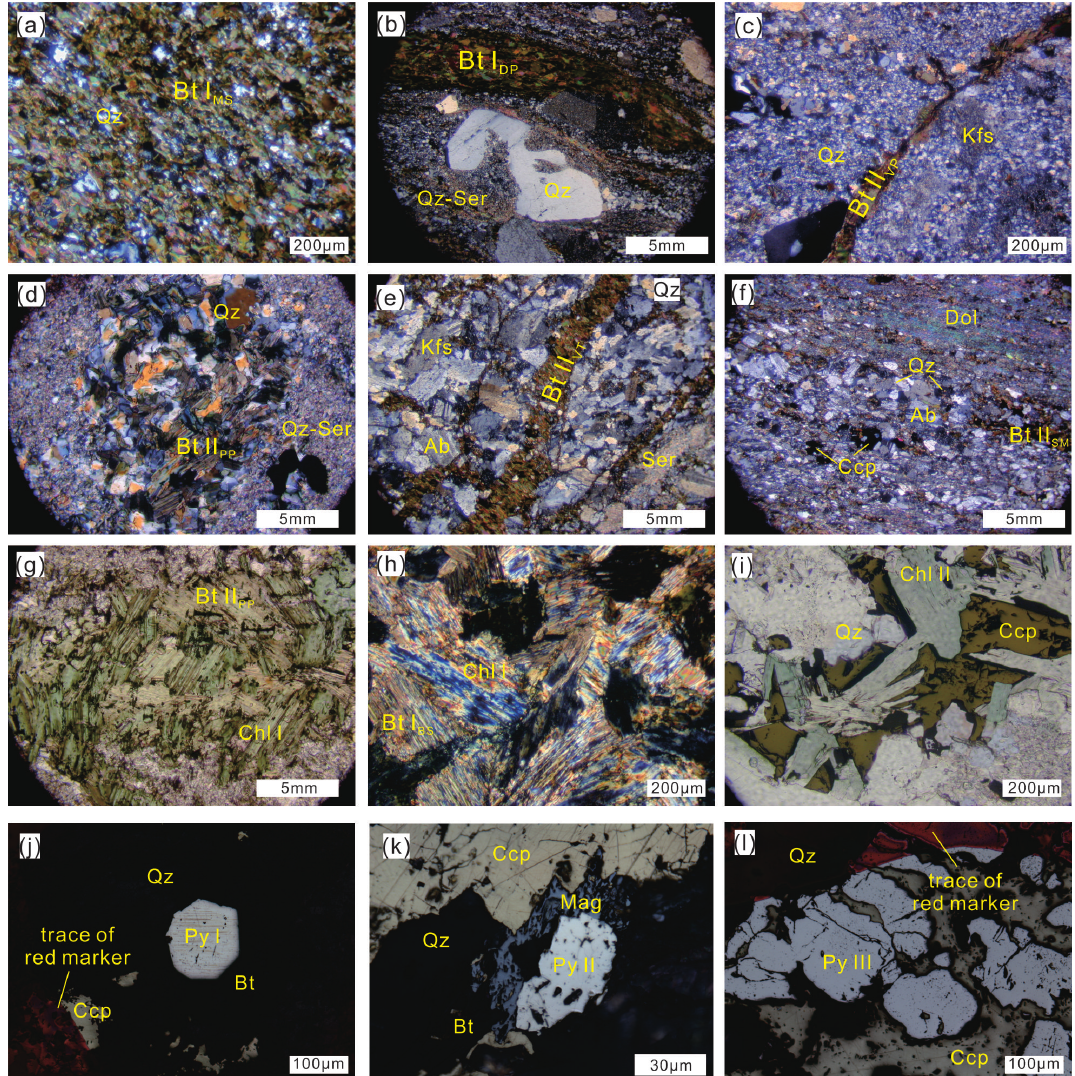
Figure 7. ( a ) Microscopic photos showing metamorphic biotite in biotite schist (Bt I BS ); ( b ) Biotite in monzogranite porphyry (Bt I DP ); ( c ) Biotite veins in monzogranite porphyry (Bt II VP ); ( d ) Secondary biotite replacing earlier phenocrystic biotite (Bt II PP ); ( e ) Biotite vein in metatuff (Bt II VT ); ( f ) Biotite growing with quartz-albite lenticulars in metatuff that overprinted by late vein-type chalcopyrite mineralization (Bt II SM ); ( g ) Chlorite replacing secondary biotite (Bt II PP ) in monzogranite porphyry; ( h ) Chlorite replacing biotite in biotite schist (Bt I BS ); ( i ) Chlorite growing with chalcopyrite in quartz vein; ( j ) Euhedral pyrite in metatuff (Py I); ( k ) Subhedral to anhedral pyrite intergrown with Bt II MT in metatuff; and ( l ) subhedral to anhedral pyrite (Py III) in quartz veins. Ab; Albite; Bt: Biotite; Chl: Chlorite; Ccp: Chalcopyrite; Dol: Dolomite; Kfs: K-feldspar; Mag: Magnetite; Qz: Quartz; Ser: